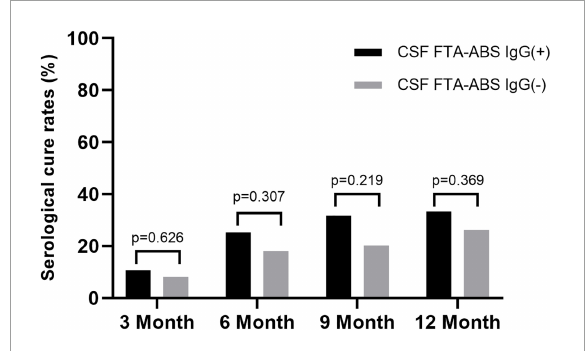
FIGURE2 Serological cure rates based on CSF FTA-ABS in ANS